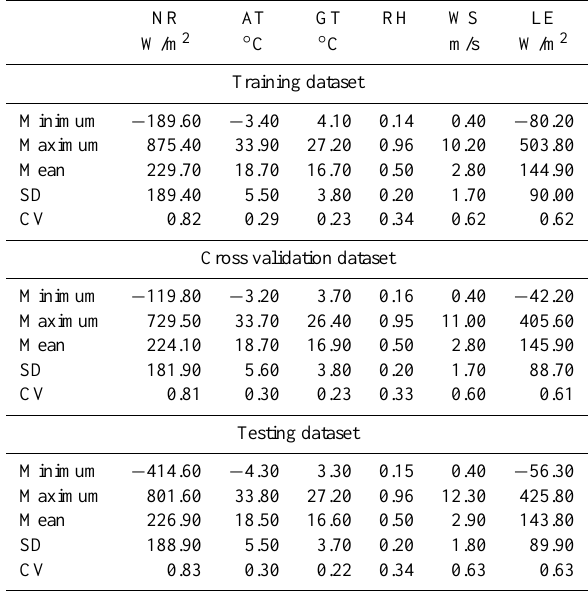
Table 1. Descriptive statistics of the AET